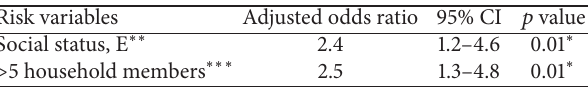
Table 4: Final model multivariate logistic regression analysis for factors potentially associated with intestinal parasite infection, among children aged 0 to 15 years, from a substandard settlement in Macei´o, Alagoas, Brazil.